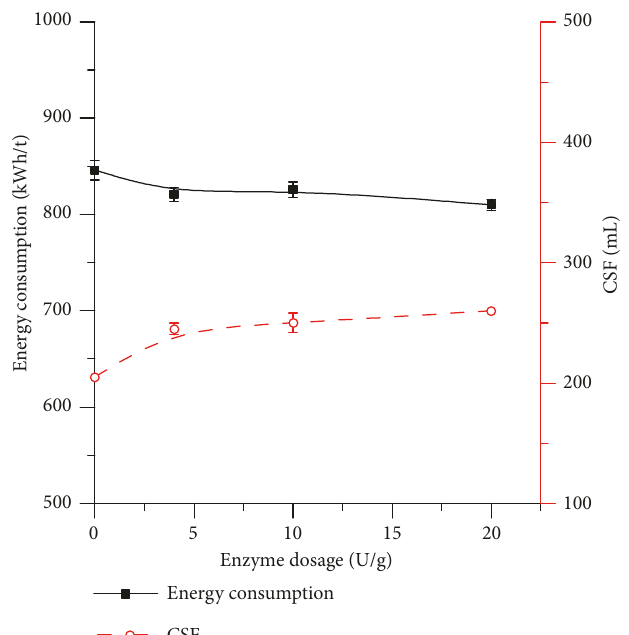
Figure 3: Effect of xylanase pretreatment on the mechanical refining of mulberry branches and the required energy consumption.